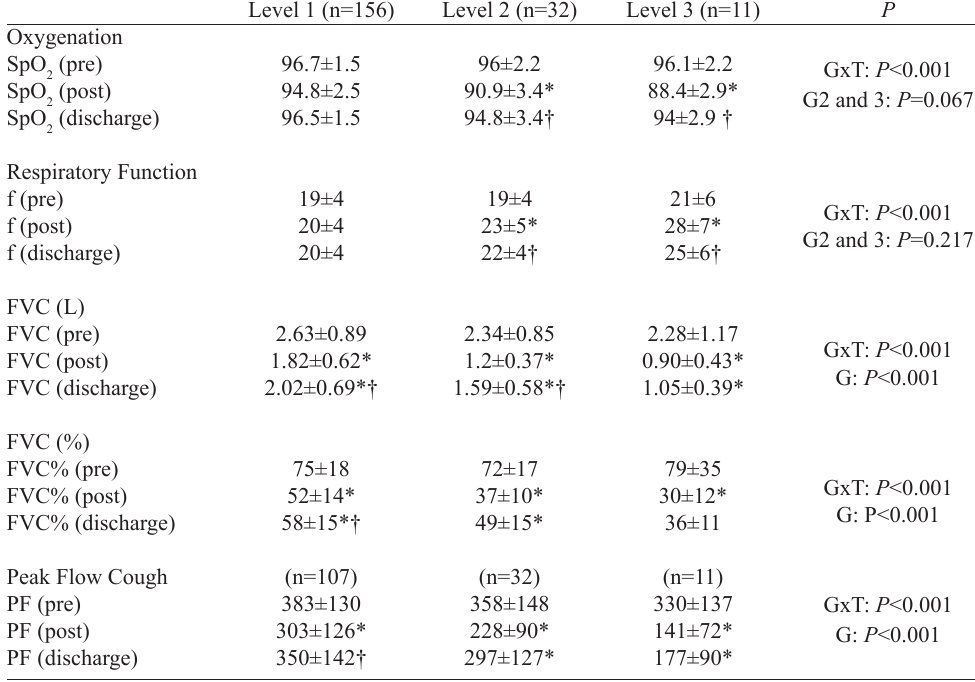
Table 4. Quantitative variables of the classification system of level 3